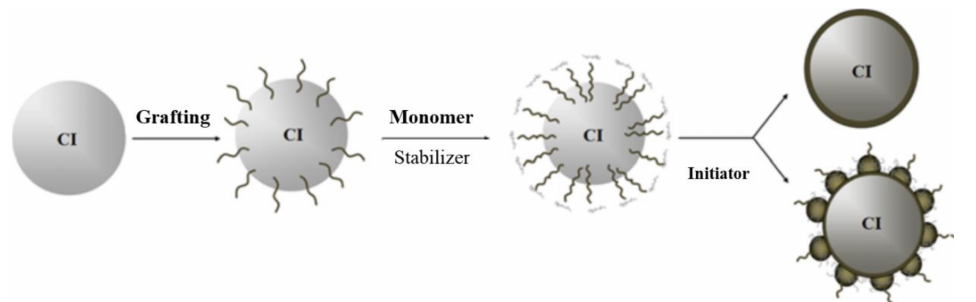
Figure 3. Schematic of the preparation process for polymer-coated carbonyl iron (CI) particles (Cho et al. [61], © IEEE, 2004).